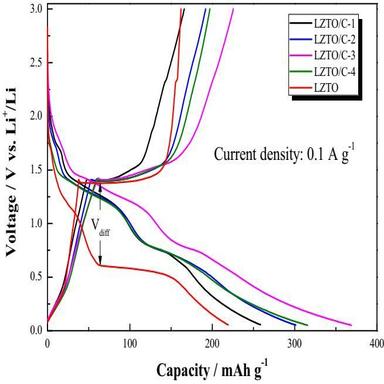
Corresponding charge/discharge voltage curves of pristine LZTO and N-doped carbon coated LZTO.